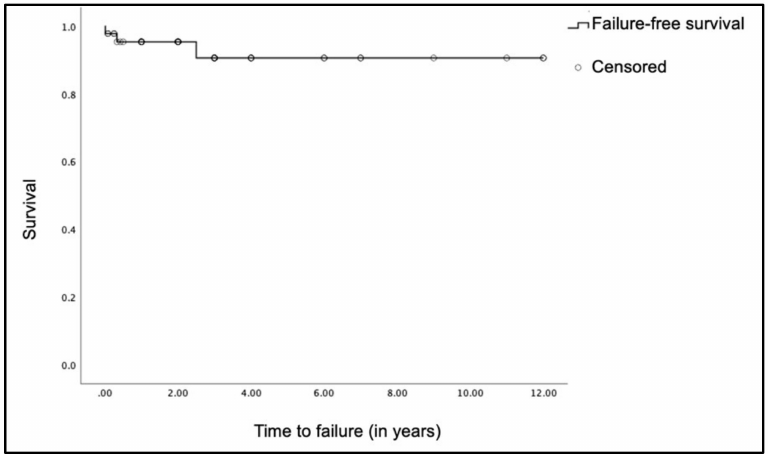
Figure 5. Failure-free survival for all PSV shunts. Table 2. Comparative mean number of adjustments per PSV before and after 2016. Mean number of adjustments per PSV